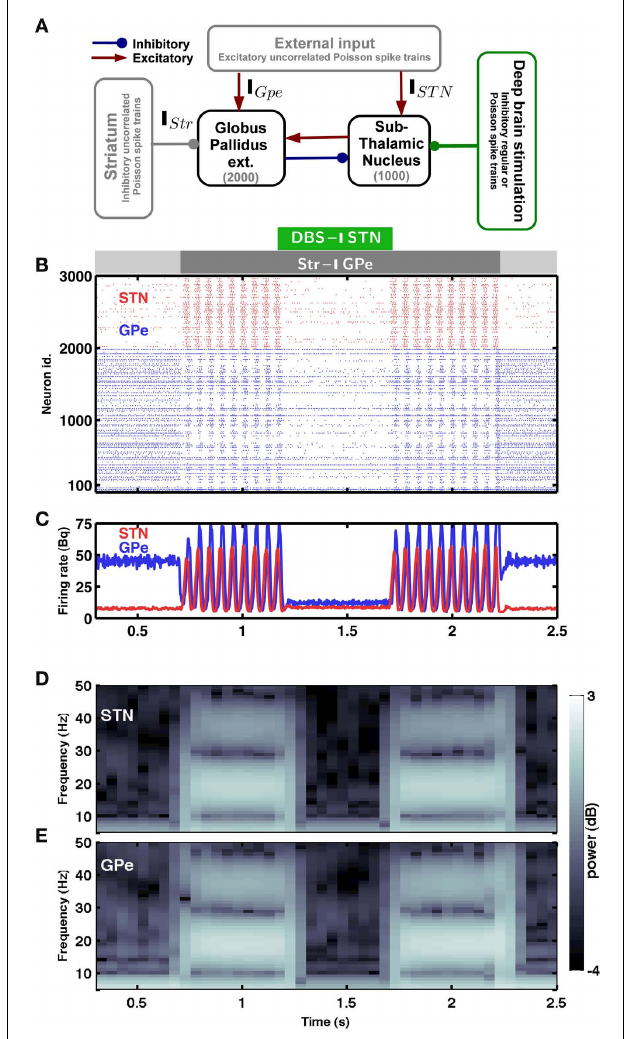
FIGURE 1 | Spiking activity in the sub-thalamic nucleus – globus pallidus network. (A) Scheme of the STN-GPe spiking neural network model. (B) Raster plot of the spiking activity of STN (red) and GPe (blue) neurons.The strength of striatal inhibition to the GPe is indicated by the light gray (weak) and dark gray (strong) horizontal bars.The green horizontal bar indicates Poisson type inhibitory stimulation of the STN. (C) Time-resolved population firing rates of the STN (red) and GPe (blue) networks. (D,E) Spectrogram of the STN (D) and GPe (E) population activity. In the presence of weak striatal inhibition to the GPe, the network exhibited asynchronous and aperiodic activity (Hauptmann et al., 2009). An increase of the striatal inhibition to GPe (dark gray horizontal bar) induced synchrony and β -band oscillations in the STN-GPe network. Such oscillations could be quenched by inhibiting the STN network with Poisson type input (green horizontal bar).The oscillations reappeared again as soon as the inhibitory stimulation of the STN was turned